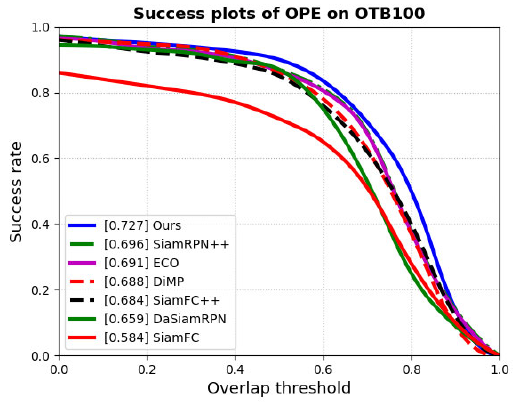
Figure 11. Success plots on OTB100.